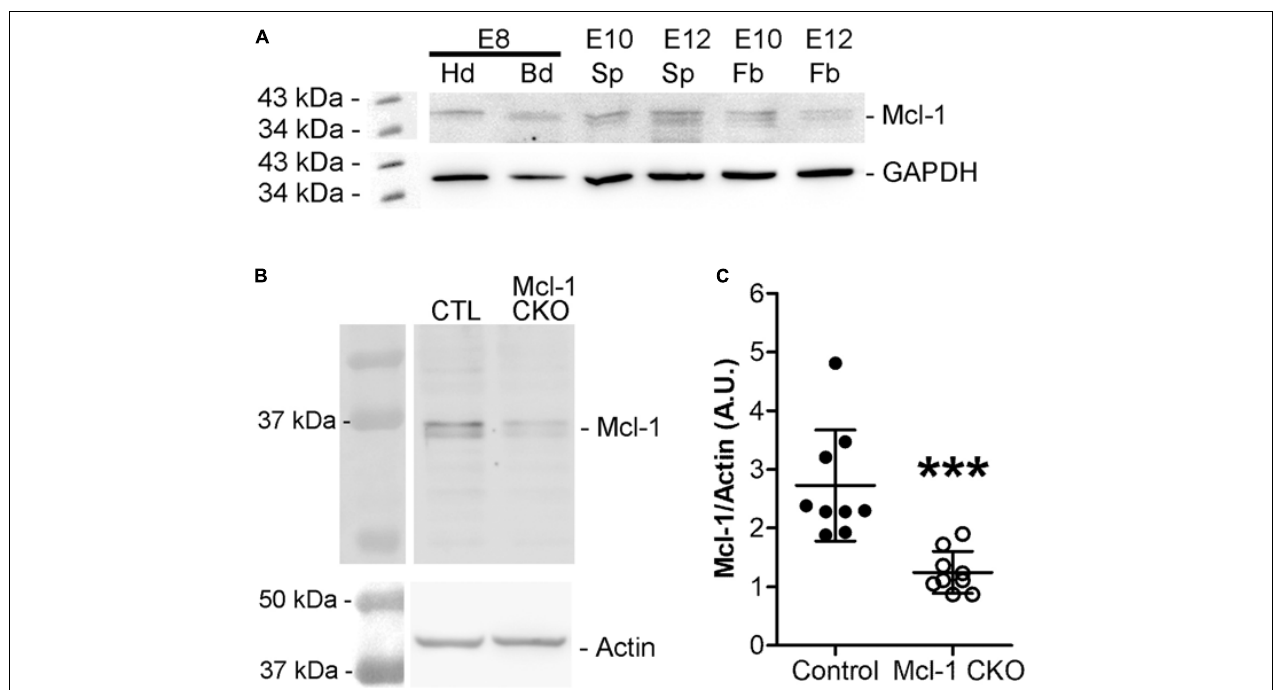
FIGURE 1 | Mcl-1 protein expression is observed at E8. (A) Western blots for Mcl-1 in C57BL/6J wild-type E8 embryonic heads compared to E10 and E12 forebrain expression ( n = 2 blots). Each E8 head sample contained one pooled litter. Each E10 sample contained three pooled nervous system samples and each E12 sample contained two pooled nervous system samples. GAPDH was used as a loading control. Hd, head, Bd, body, Sp, spinal cord, and Fb, forebrain (B) Western analysis of Mcl-1 protein expression in developing nervous system of E10 Mcl-1 CKO and littermate controls. (C) Densitometry analysis of Mcl-1 protein levels. Mcl-1 protein levels (A.U.) were normalized to actin ( n = 9 samples/genotype) *** p < 0.001 , error bars represent ±